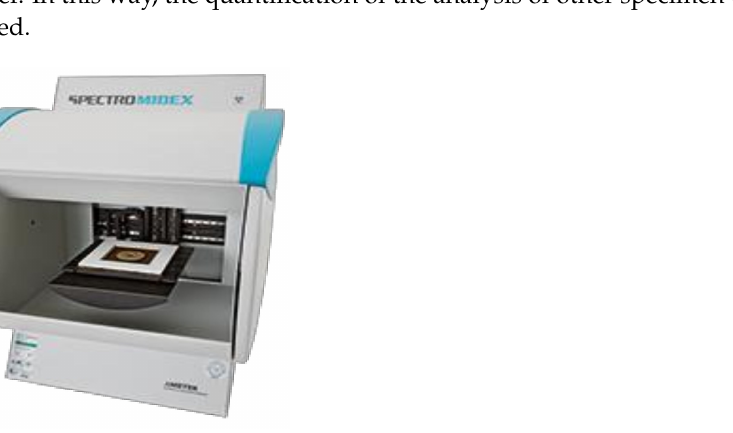
Figure 2. X-ray fluorescence (XRF) spectrometer SpectroMidex (AMETEC, Kleve,